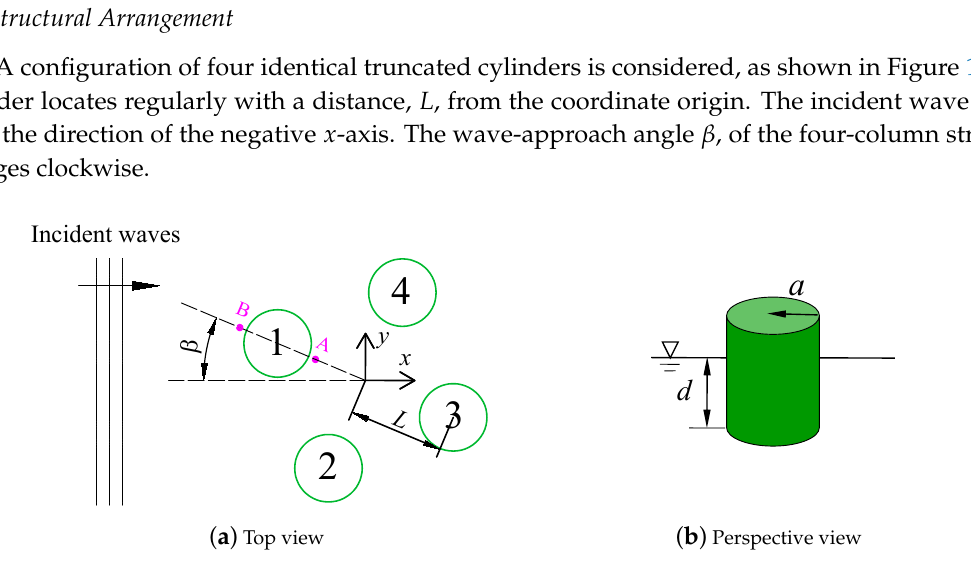
Figure 1. Notation of parameters: ( a ) wave-approach angle β and parameter L ; ( b ) radius a and draft d of the